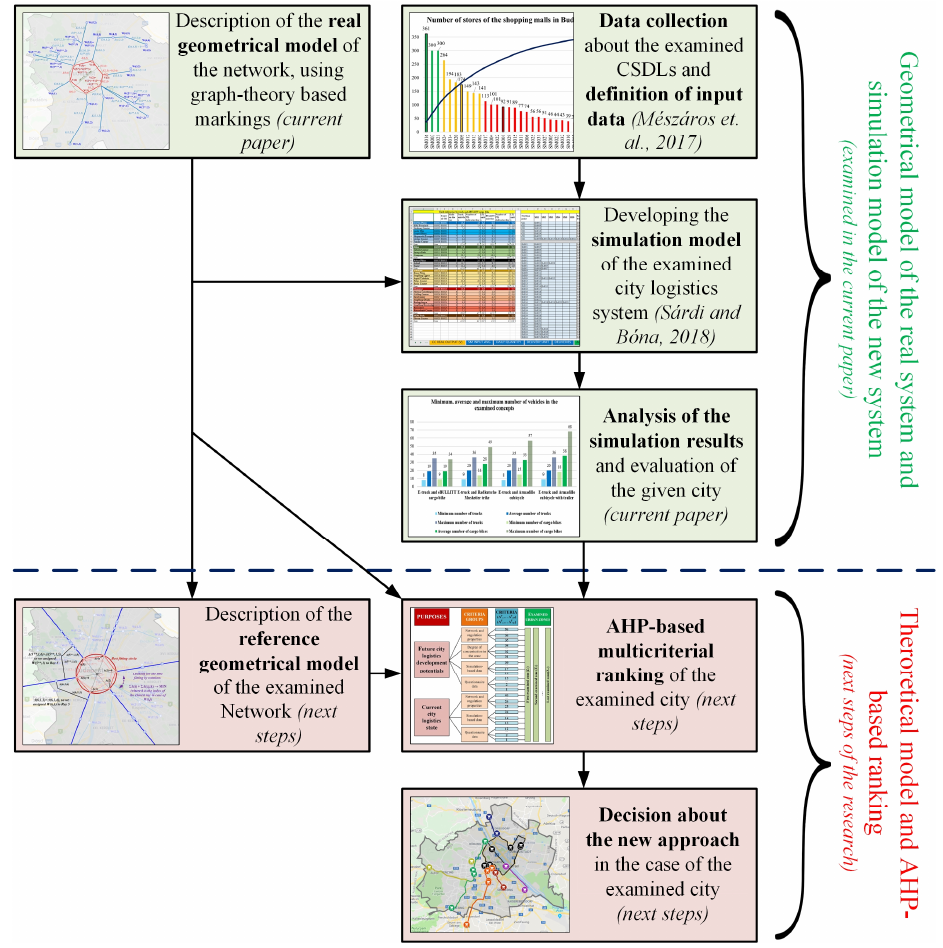
Figure 18. Application of the geometrical model-based approach.